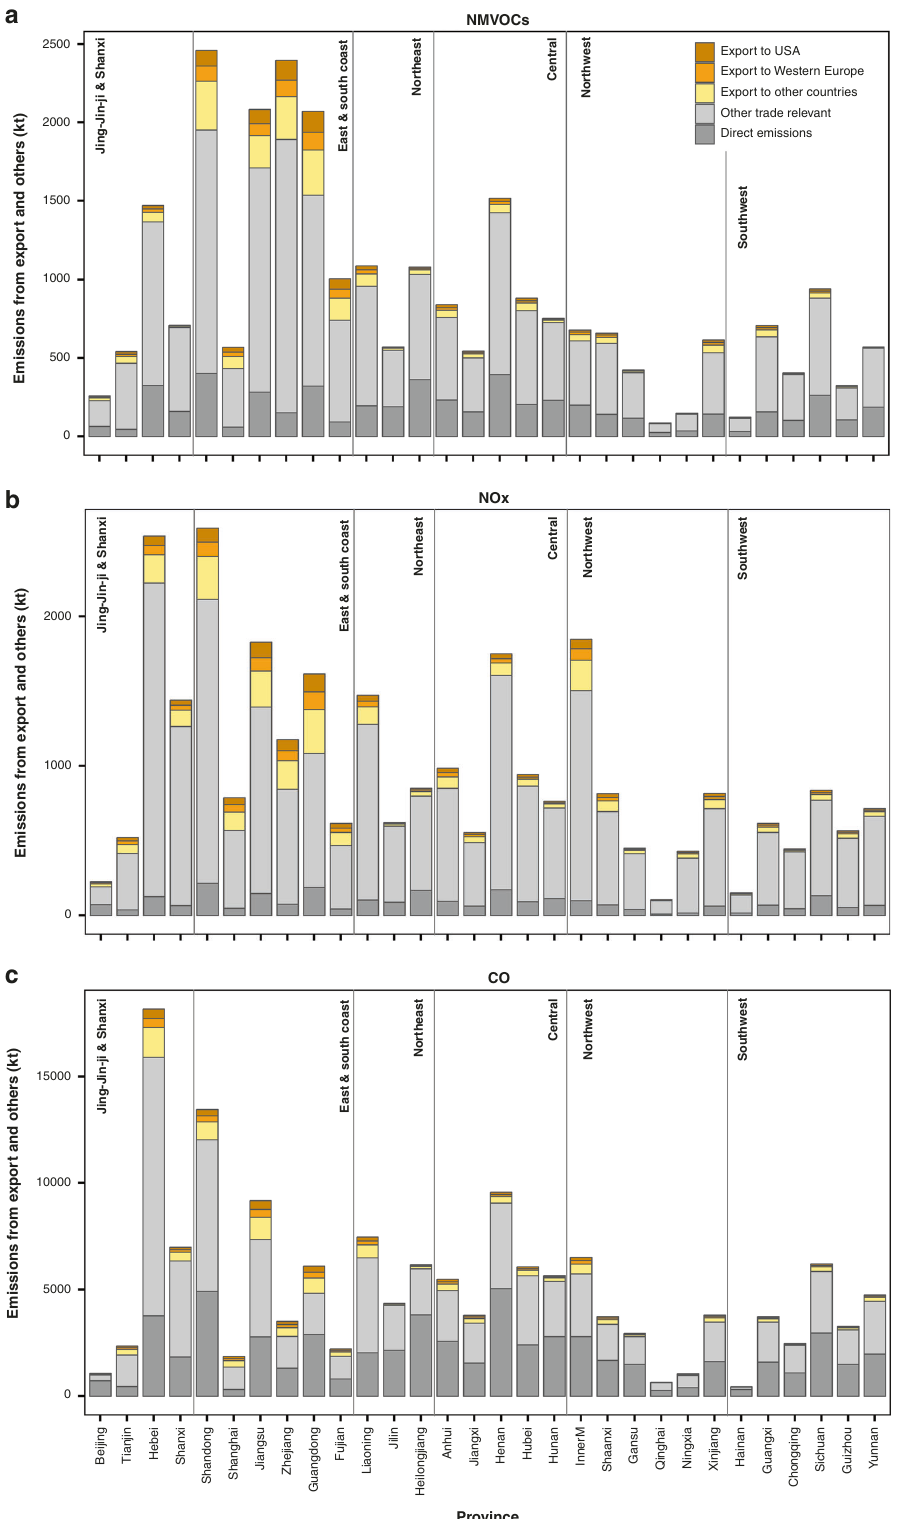
Fig. 1 China ’ s provincial emissions driven by export and domestic demands in 2013. a NMVOCs. Export-driven emissions stood out in the east and south coast, e.g., Shandong, Jiangsu, Zhejiang and Guangdong. Demands from the United States (USA) and western Europe explained nearly half the export- relevant emissions. b NOx. Export contributed to 15% national sum of NOx emissions. Export-embodied emissions were notable in the east and south coast, as well as other inland provinces such as Inner Mongolia and Hebei. c CO. About 10% CO emissions in China were driven by export. Impacts of export were highlighted in Hebei, Shandong and Jiangsu. Source data are provided as a Source Data fi